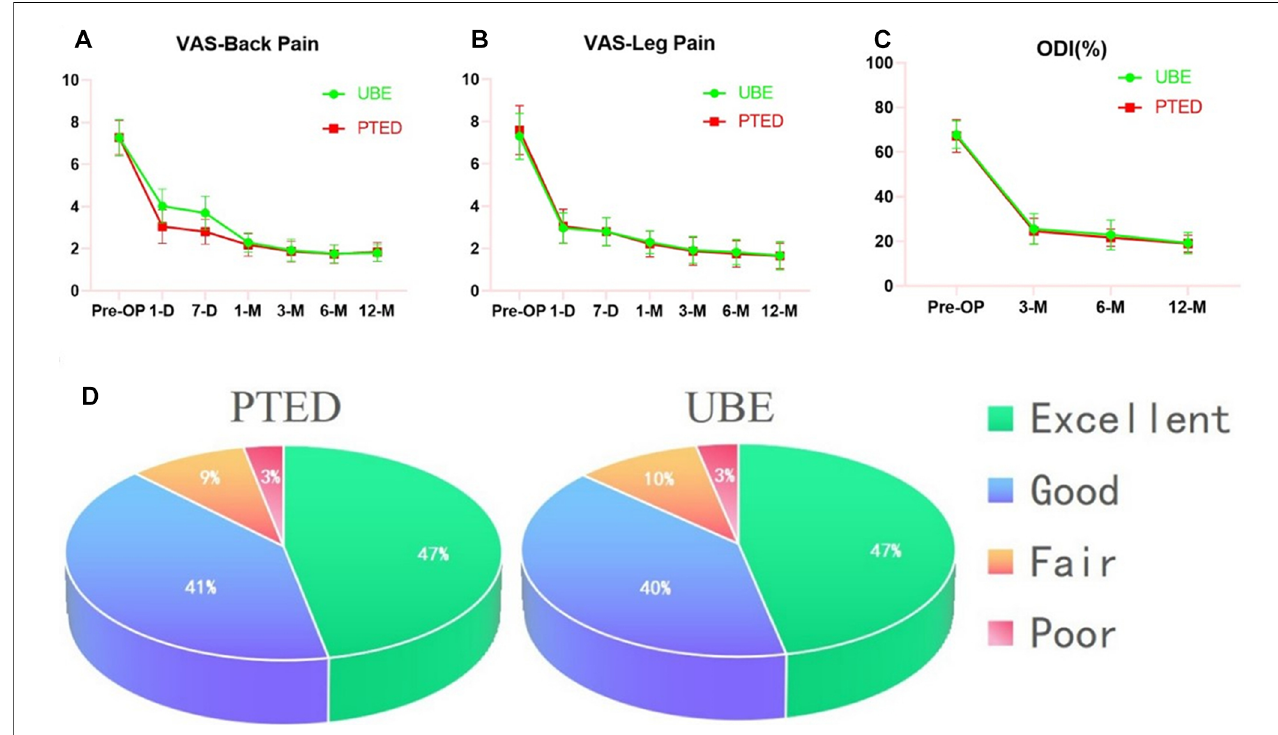
FIGURE 5 Clinical outcomes at different follow-up time points. ( A ) VAS score for back pain in both groups. ( B ) VAS score for leg pain in both groups. ( C ) ODI score for both groups. ( D ) The modi fi ed MacNab for both